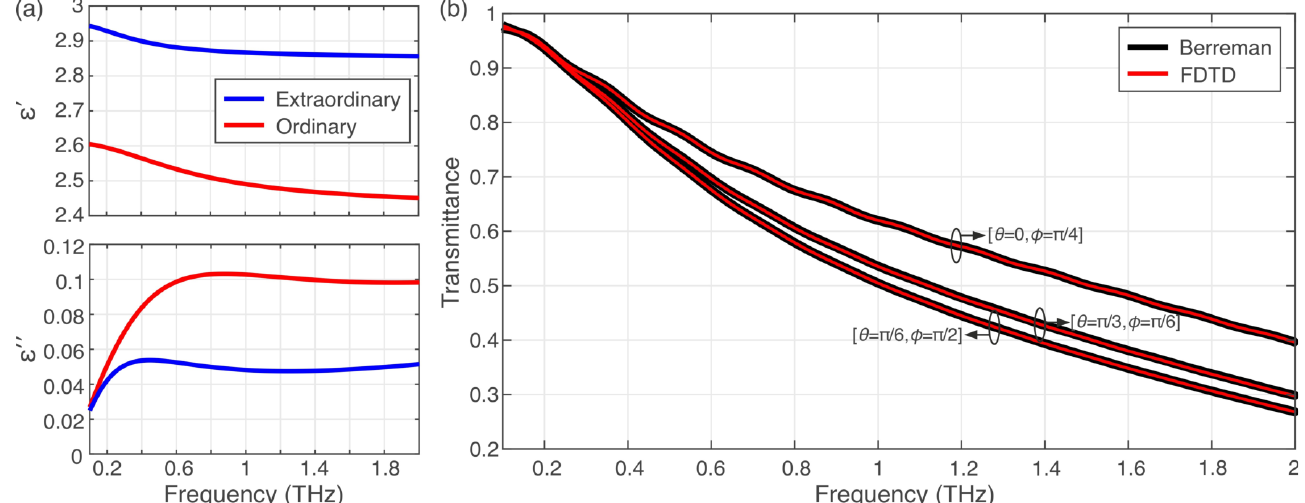
Figure 2. ( a ) The ordinary and extraordinary relative permittivities of 5CB in the low THz spectrum. ( b ) Transmittance calculated by the proposed FDTD method and the Berreman